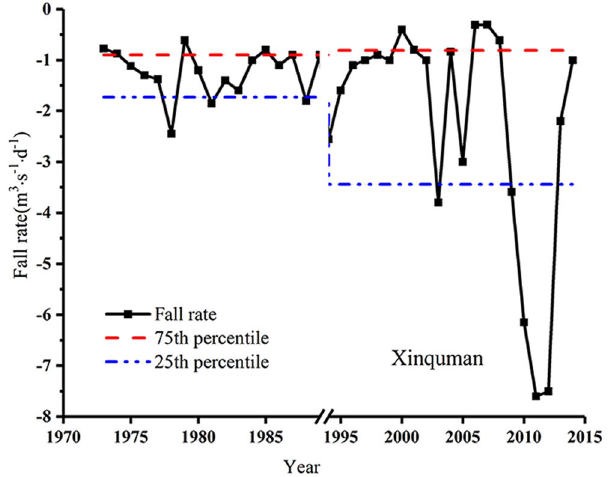
Figure 5. The average flow reduction rate during 1973 to 2014 at Xinquman station.